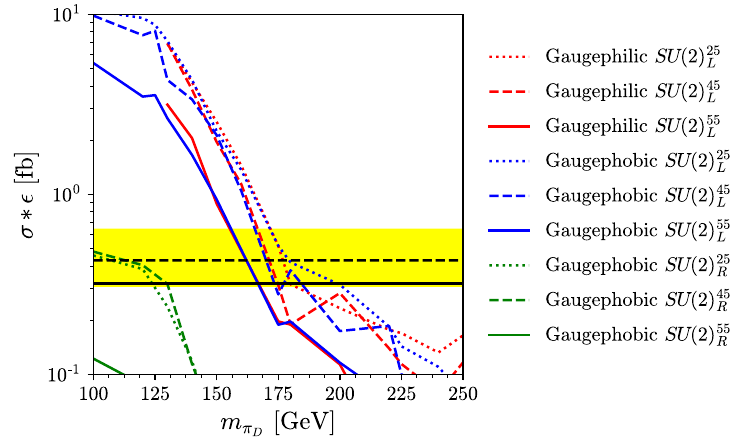
Figure 8 . Exclusions from the ATLAS search for supersymmetry in final states with tau lep- tons [147]. The dark mesons on the lighter side of our spectrum predominately decay to taus, and the cross sections are large. The SU(2) type models are excluded if m L models limits are around 130 GeV. This is the only search which limits the SU(2) SU(2) R can decay to π where the ρ D D π D